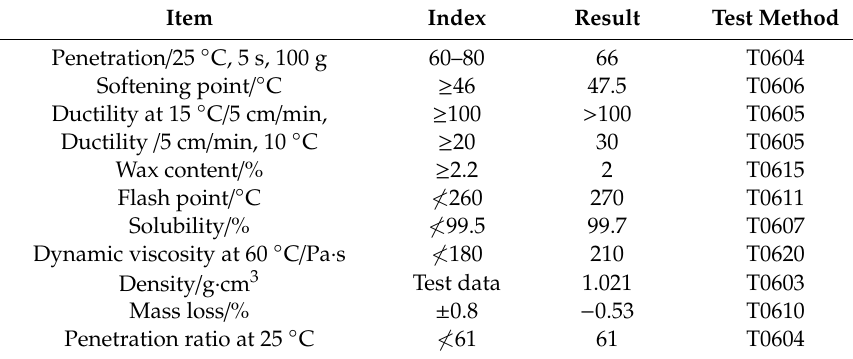
Table 2. Physical properties of modified asphalt with penetration grade of 30/60 pen.